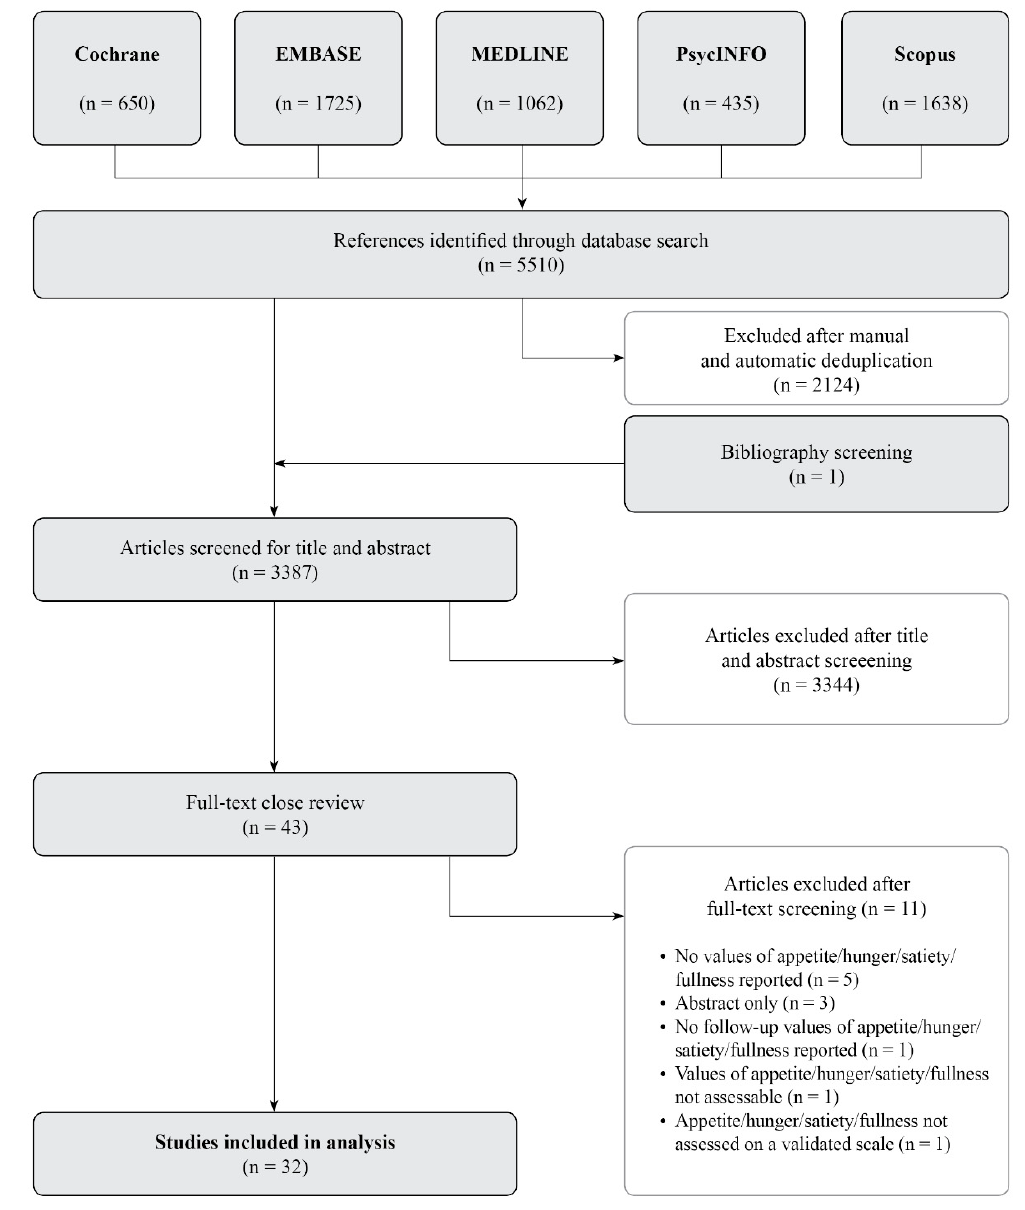
Figure 1. Systematic review flowchart.